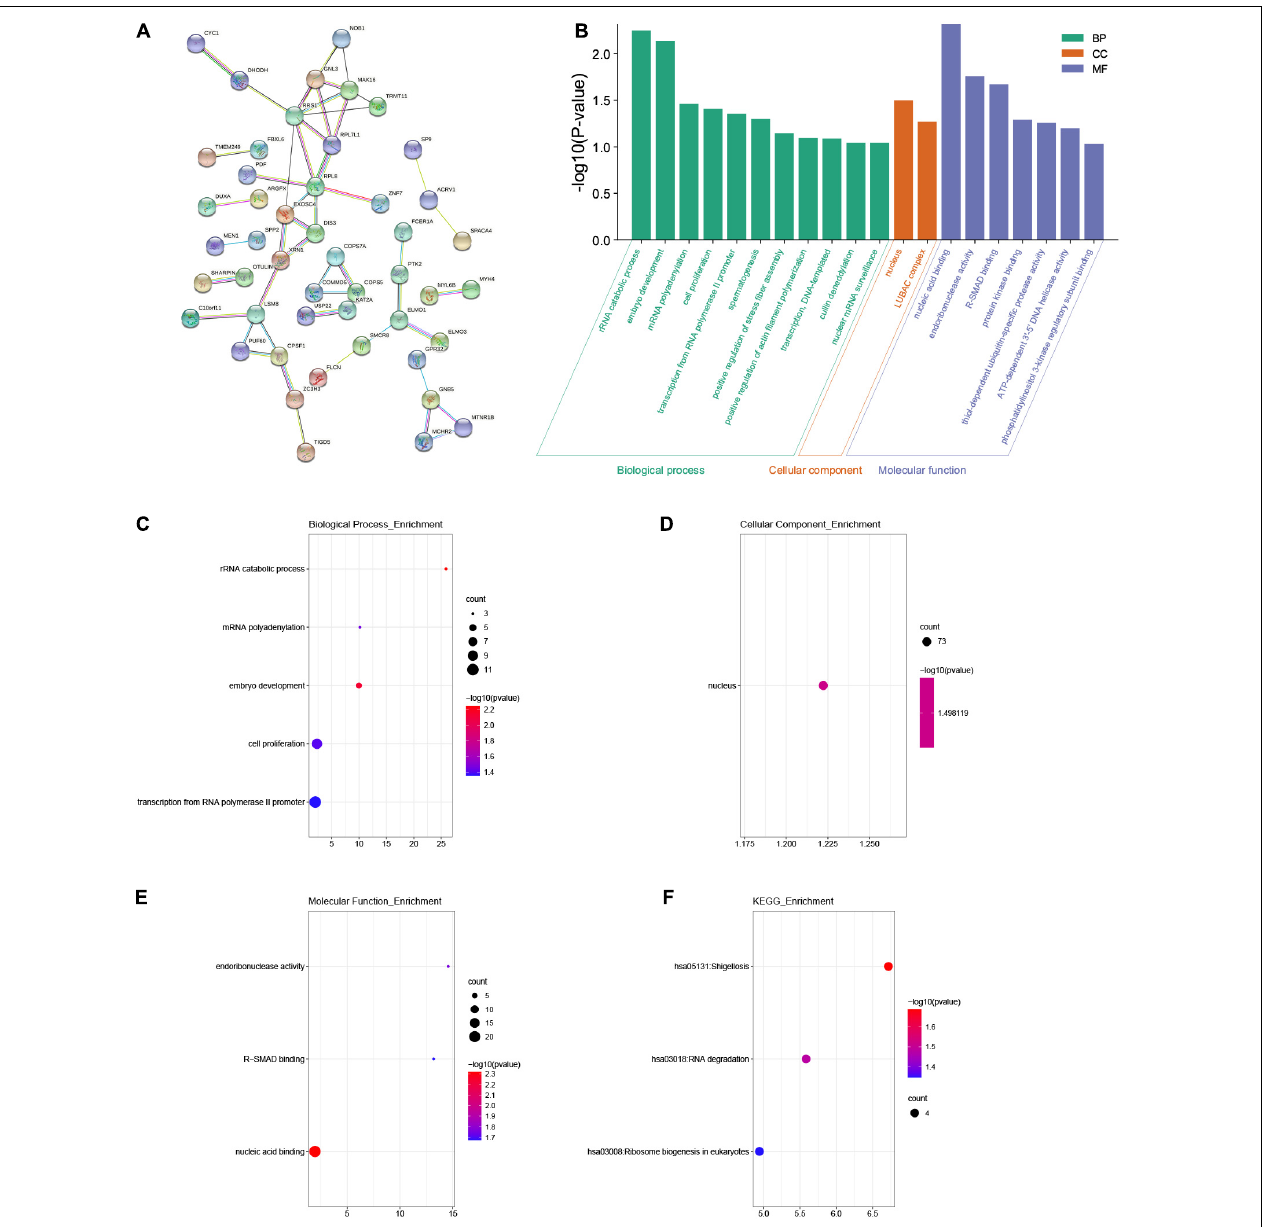
FIGURE 6 | The enrichment analysis of FAM83 family members and their 259 co-expression genes in STAD patients (STRING and DAVID). (A) The PPI network with high confidence (0.7) and hide disconnected nodes in the network. The nodes meant proteins, and the edges meant protein interaction. (B) Displayed the results of GO enrichment analysis with bar graphs. (C–E) BP, CC and MF in GO enrichment analysis. (F) KEGG enrichment